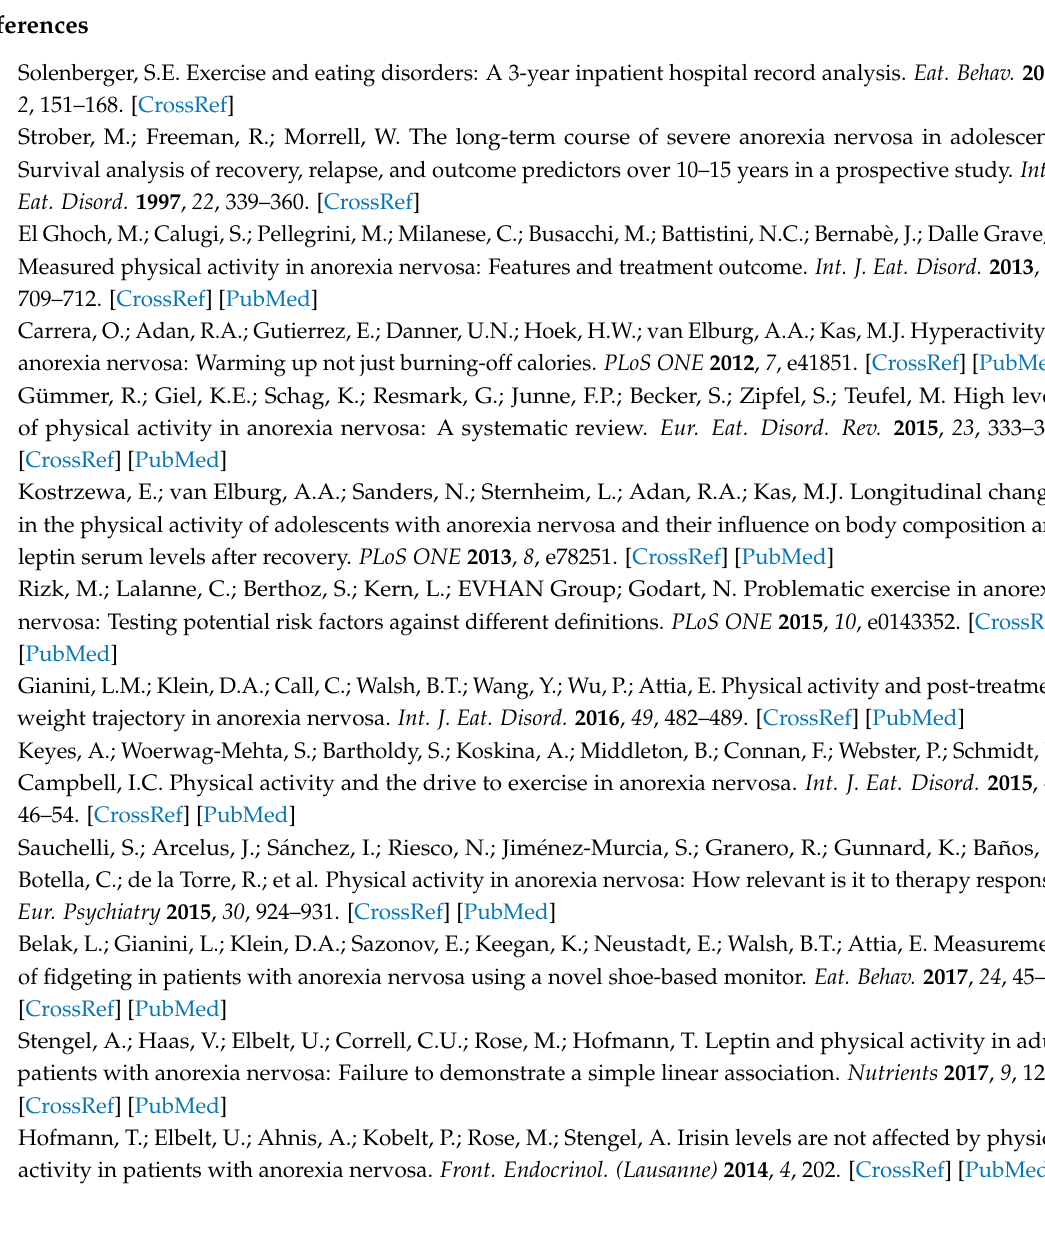
Table S1: Medical details, comorbidities, and medication of study patients and the healthy